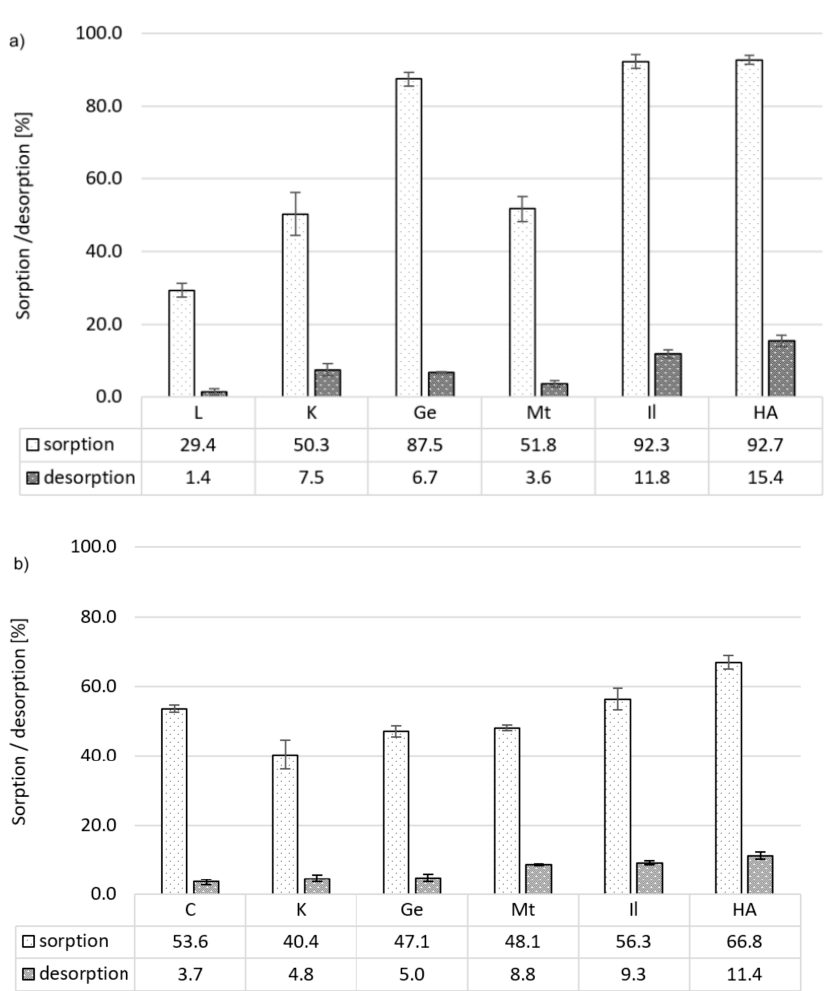
Figure 4. Comparison of sorption and desorption magnitude for carbaryl in ( a ) soil L and ( b ) soil C. Error bars represent standard deviation of triplicate samples.